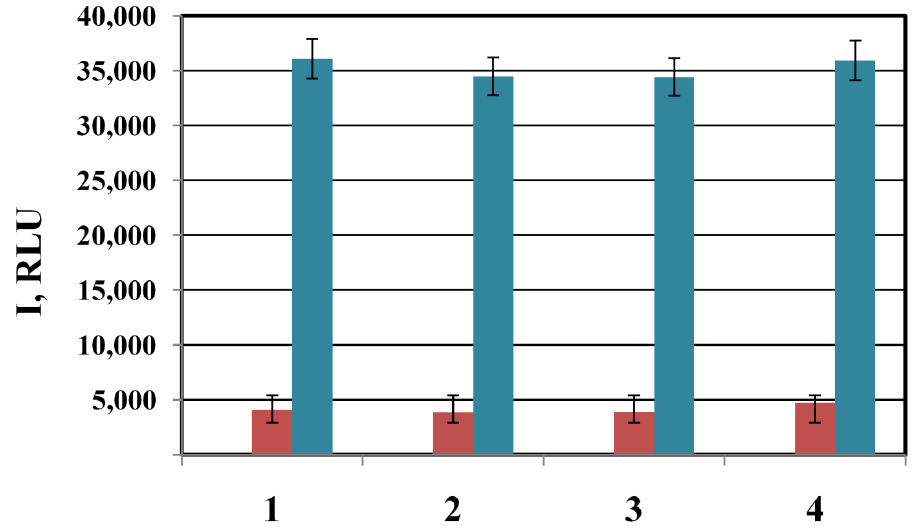
Figure 10. Determination of different target DNAs containing bla TEM-1 (1), bla TEM-3 (2), bla TEM-37 (3), bla TEM-9 (4) on nitrocellulose microarrays. Detection of AuNPs with an enhancement solution at optimized concentrations (blue); detection of AuNPs without enhancement (red). Concentration of target DNA 3 nM.